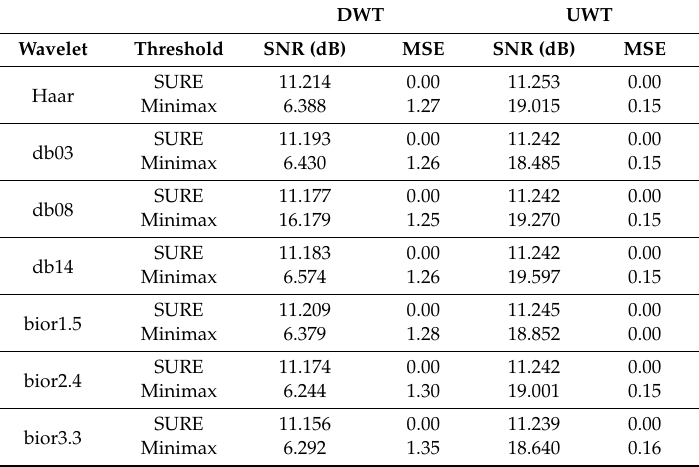
Table 1. SNR and MSE values when denoising the EOG signal using DWT and UWT with different wavelets and threshold